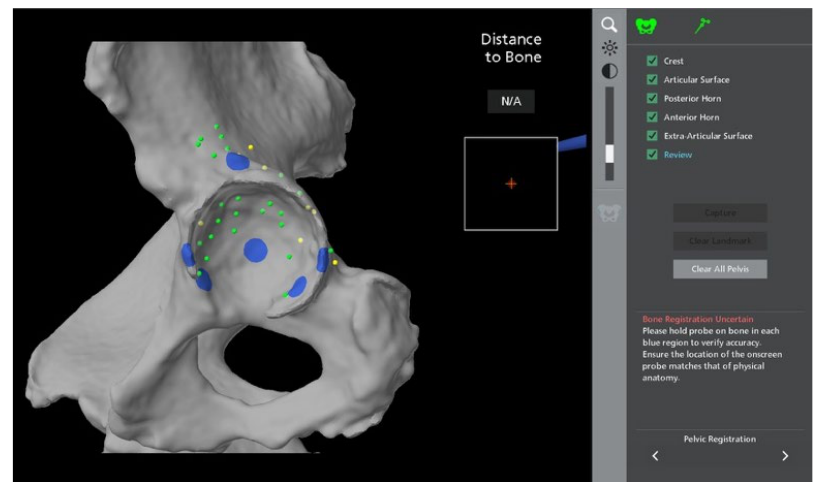
Figure 7. Pelvic registration. The blue areas are checkpoints to be verified with the probe, as listed on the top right of the image. The green dots indicate where the probe has registered points exactly as planned, and yellow dots indicate where the registration is slightly off plane.